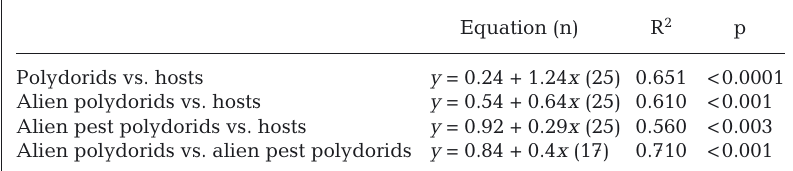
Table 3. Relationships between the number of mollusc hosts cultured per country and the number of non-indigenous polydorids and non-indigenous polydorid pest species recorded in those countries. Relationships were significant at p <